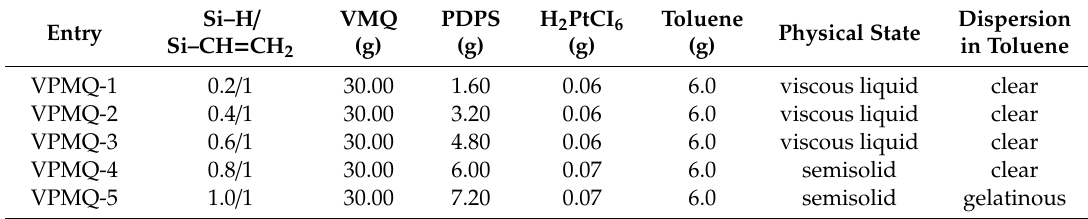
Table 1. The formulations of VPMQ